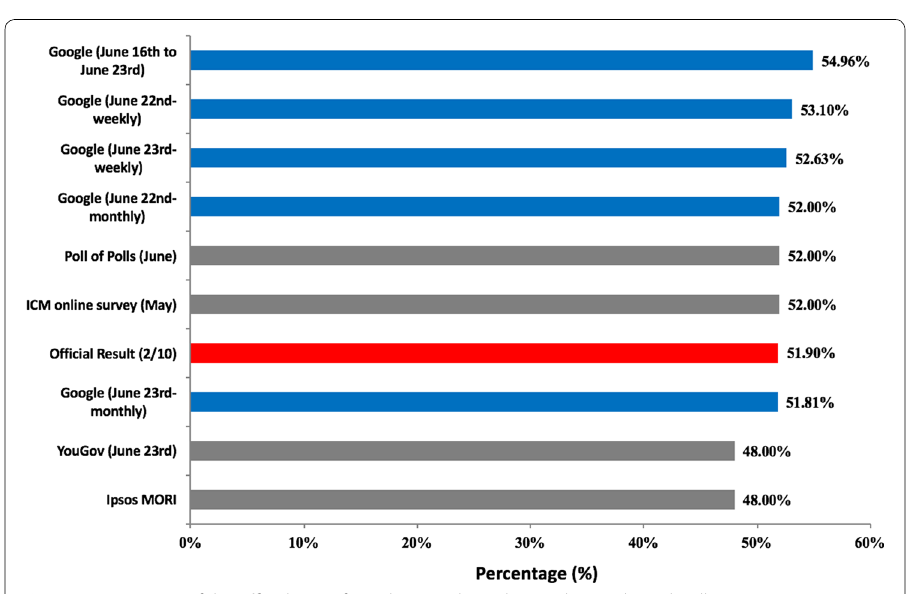
Fig. 3 Comparisons of the official UK Referendum results with Google Trends, and poll